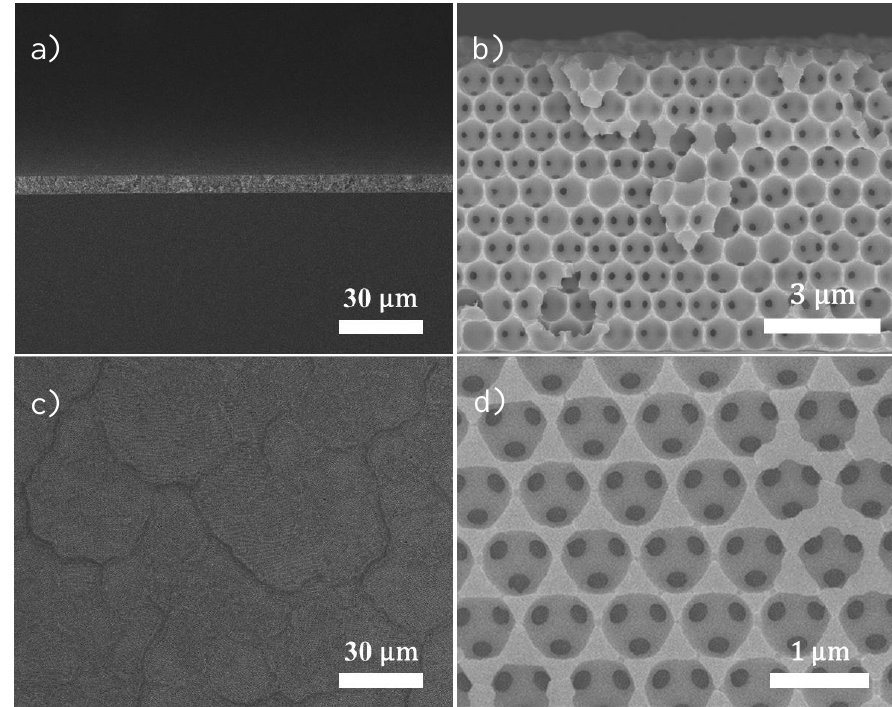
Figure 2. The SEM images for Ni inverse opals in cross-sectional view; ( a ) low magnification and ( b ) high magnification, as well as in top view; ( c ) low magnification and ( d ) high magnification.